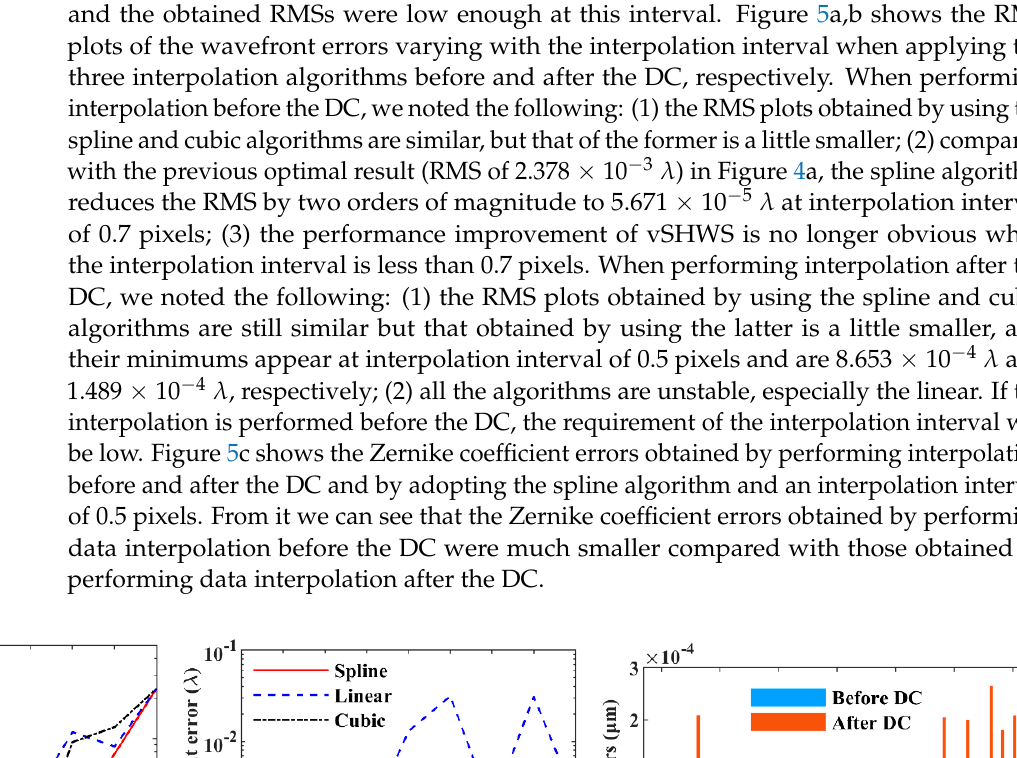
( c ) Figure 6. Results of vSHWS with optimizing parameters. ( a ) Zernike coefficients; ( b ) Zernike coefficient errors; ( c ) wave- front error. 3.6. Anti-Noise Performance The effect of the parameter optimizations on the anti-noise performance of vSHWS was also investigated. Different white Gaussian noises were added to W P to generate the wavefronts with different signal-to-noise ratios (SNRs), which were calculated in decibel units on 10·log10. These wavefronts were then reconstructed by using the non-optimized and optimized vSHWS, respectively. The non-optimized vSHWS was configured as fol- lows: square virtual lenslets, sub-aperture number of 20 × 20, expansion ratio of 1.2 times for the zero-padding of E 0 , and no data interpolation. The real part of E with an SNR of 30